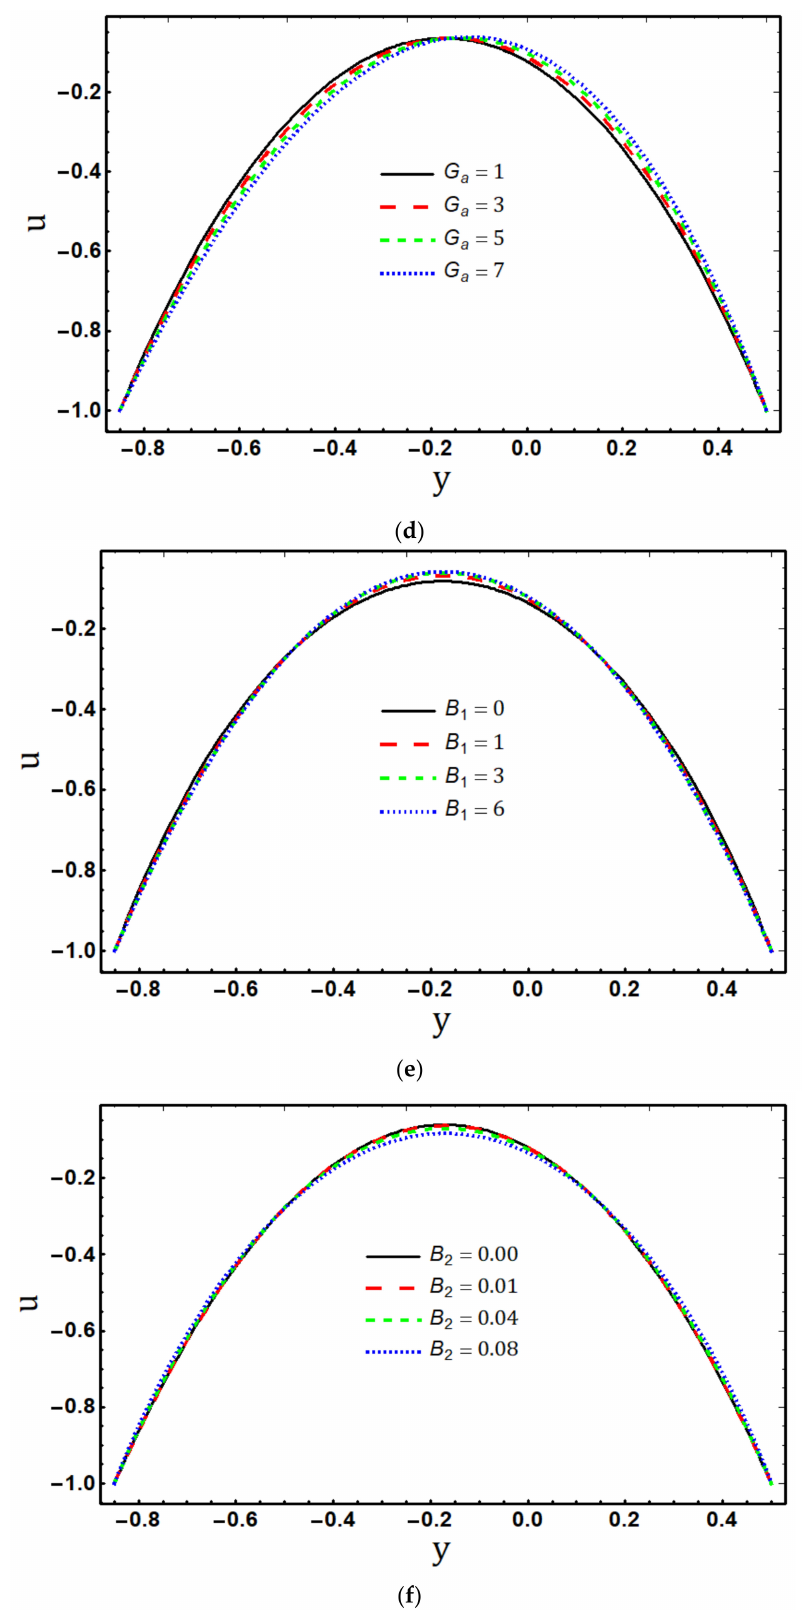
Figure 2. ( a ): Effects of m e on u , while other parameters are b 1 = 0.3, b 2 = 0.5, x = 0.5, l = 1, ζ 1 = − 0.9, ζ 2 = − 0.8, U HS = − 0.9, Θ = 1.5, Φ = π /3, α = π /3, Ha = 0.1, B 1 = 2, M 1 = 1, B 2 = 0.02, G t = 0.6, G a = 0.5, Sc = 1.5, M 2 = 2, γ = 0.6, Br = 0.5. ( b ): Effects of Ha on u , while